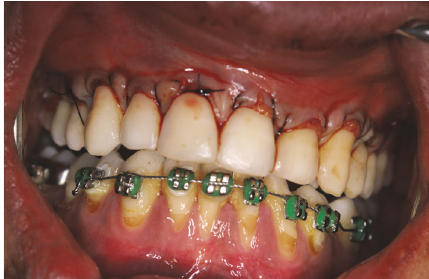
Figure 10: Stabilization and suture of the platelet-rich fibrin mem- branes.